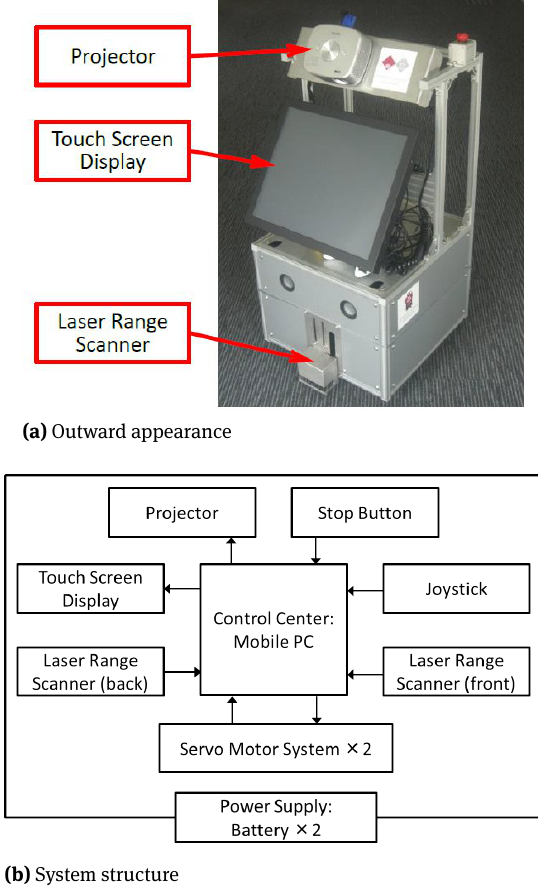
Fig. 4. Mobile Robot HFAMRO-3. to project a rectangular area on the floor in different dis- tances and different sizes using its keystone function. Two laser range scanners URG-04LX-UG01 [48] by Hokuyo Au- tomatic, having a 240-degree range from 20 to 4000 mm of measurement, are installed upside down at the front and the back of the robot. The scanning level of the range scan- ner is only about 2cm above the ground, so it can be used to detect a person’s steps.